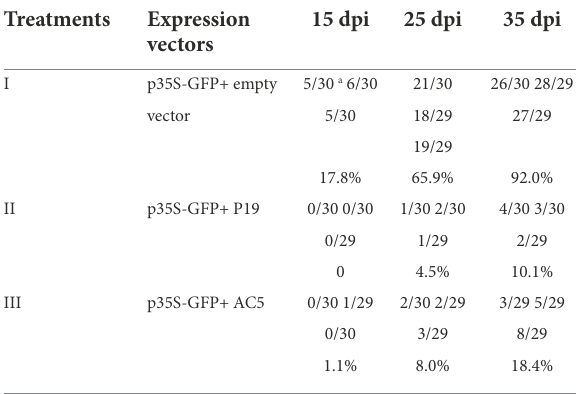
TABLE 1 The SLCCNV AC5 protein interfered spread of GFP RNA systemic silencing signal in the GFP transgenic 16c plants. Treatments